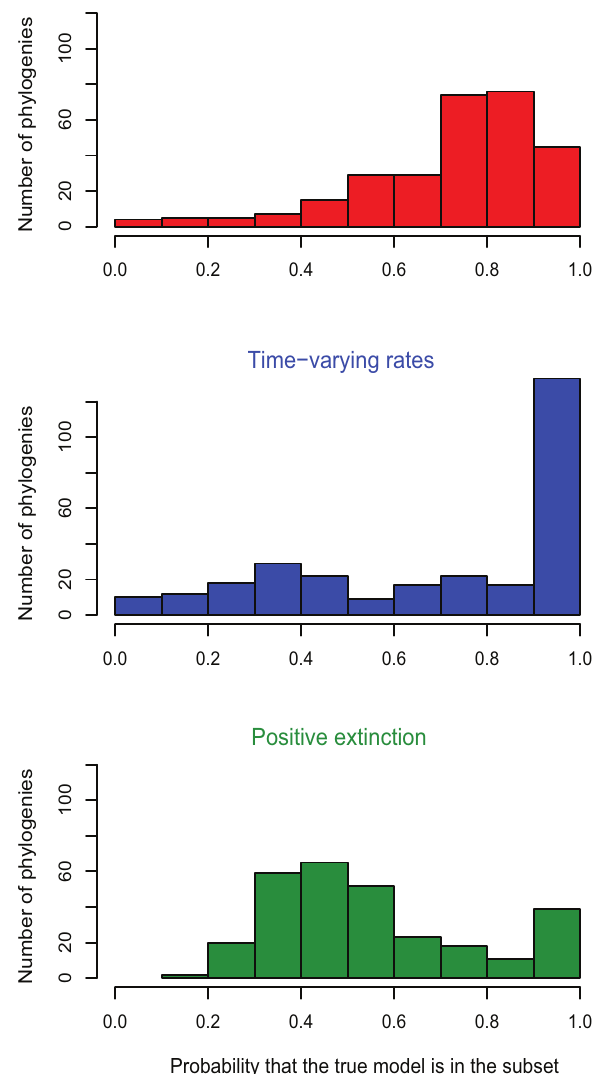
Figure 5. Dynamics of diversification among 289 empirical phylogenies. The red histogram shows, for each of the 289 phylogenies, the relative probability of the best model with expanding diversity versus the best model with saturated diversity. The blue histogram shows the relative probability of the best model with time- varying rates versus the best model with constant rates. The green histogram shows the relative probability of the best model with positive extinction versus the best model without extinction. The relative probabilities of two models are calculated using their Akaike weights. Most empirical phylogenies are consistent with the hypotheses that diversity is expanding (in red) and that speciation rates vary through time (in blue). Extinction is not detected in most phylogenies (in